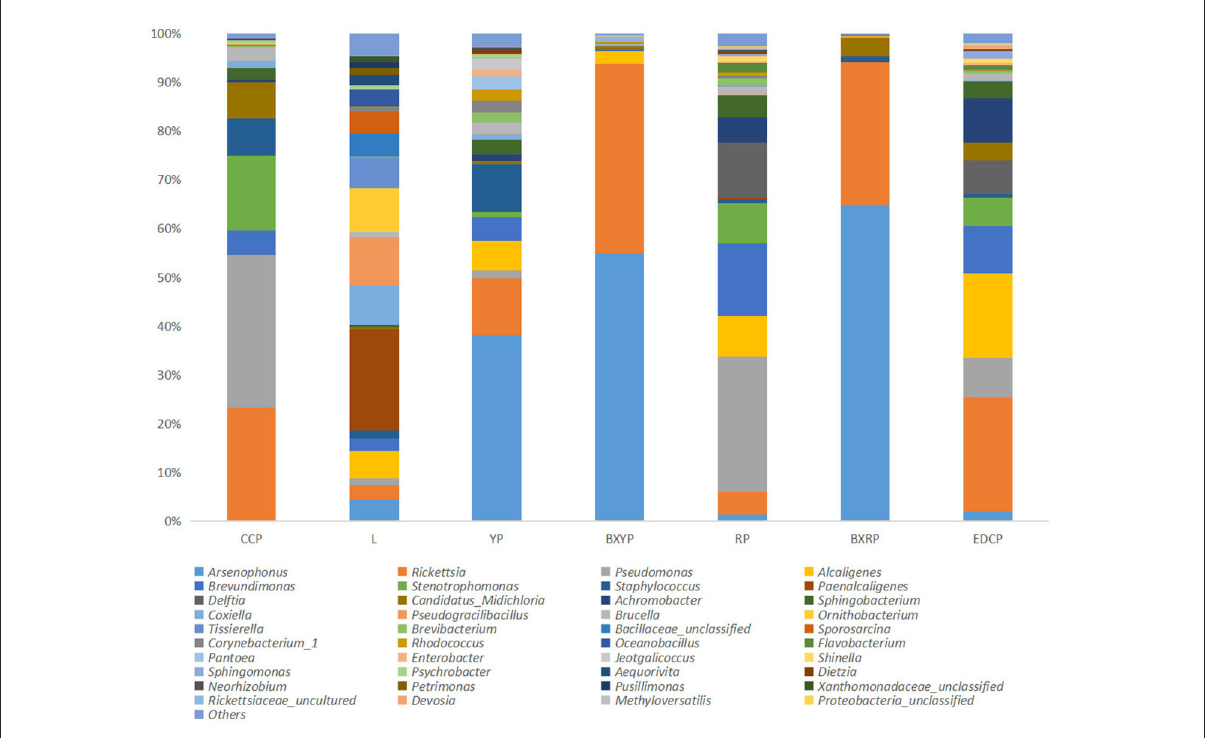
FIGURE6 Microbial community bar plot of bacterial genus of seven samples.